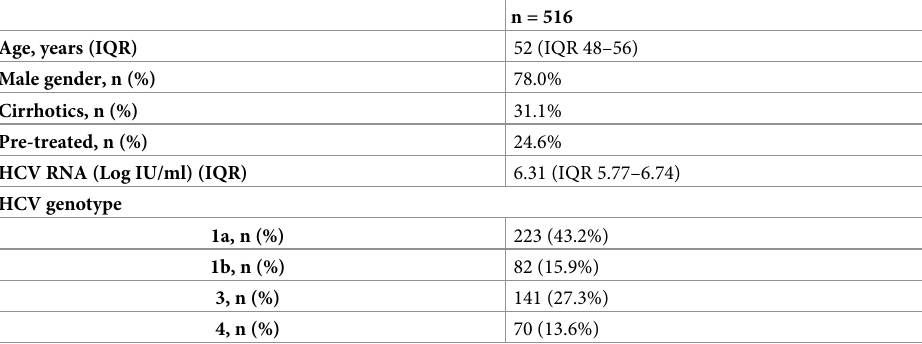
Table 1. Baseline characteristics of the